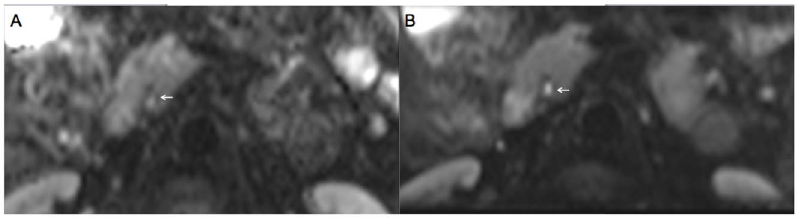
Figure 1. A 47-year old patient with c-EPI DWI (A) and z-EPI DWI (B) of the pancreas. z-EPI DWI demonstrates less distortion and a more homogeneous delineation of the pancreatic head and the main pancreatic duct (arrow).